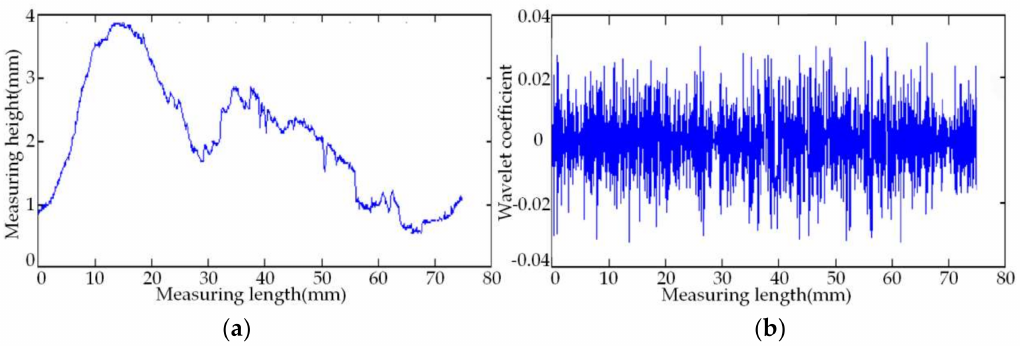
Figure 10. The original data and its wavelet coefficient. ( a ) The original data of denoising algorithm; ( b ) the wavelet coefficient of original data.